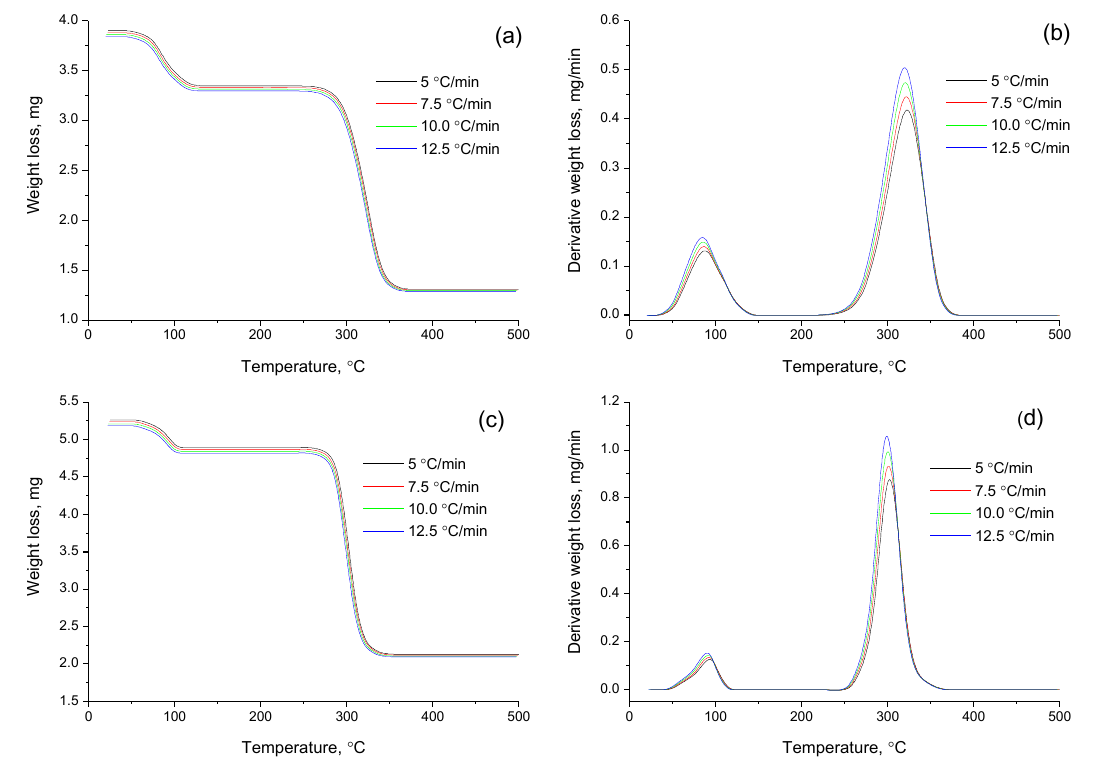
Figure 9. TG curves of the analysis of β -CD–resveratrol inclusion complexes that were obtained at ratios of 2:1 ( a , b ) and 4:1 ( c , d ) at heating rates from 5 to 12.5 ◦ C/min. According to the experimental data of the thermogravimetric analysis, it can be seen that the thermal decomposition of the inclusion complexes of β -cyclodextrin with resveratrol at ratios of 2:1 and 4:1 occurred with slight differences. As follows from the data in Figure 9a, when the β -CD–resveratrol clathrate was heated (2:1), a noticeable decrease in mass began at a temperature of ~50 ◦ C. This temperature value refers to the release of water molecules from the inner cavity of the clathrate [24]. In the case of β -CD–resveratrol (4:1) (Figure 9a,b), the endothermic peak (T onset = 50 ◦ C) associated with water loss was present, but it was less pronounced. Thermograms (Figure 9a,b) of β -CD–resveratrol clathrates show characteristic thermal effects occurring at a temperature of 230–380 ◦ C for β -CD–resveratrol complexes (2:1), and at 250–370 ◦ C for β -CD–resveratrol complexes (4:1). A comparative analysis of the data shows that the peak heat absorption caused by the activation of thermal degradation of β -cyclodextrin was in the range of 290–380 ◦ C for pure β -cyclodextrin, and 230–380 ◦ C for β -CD–resveratrol clathrates (Figure 9). These data indicate a decrease in the thermal stability of cyclodextrin when resveratrol is included in its cavity. This phenomenon can be considered proof of the formation of stable β - CD–resveratrol inclusion complexes (2:1, 4:1) and strong intermolecular bonds due to the formation of van der Waals hydrophobic forces that break down with increasing temperatures, while the β -CD molecule itself begins to break down at a higher temperatures (T onset = 290 ◦ C) (Figure 9). Based on this information, the thermal decomposition reactions and recrystallization changes were as follows: → β -CD-resveratrol (s) + H β -CD-resveratrol · H 2 O (s) 2 O (g); β -CD-resveratrol (s) → β -CD (s) + resveratrol (s); β -CD (s) → CO 2 (g) + H 2 O